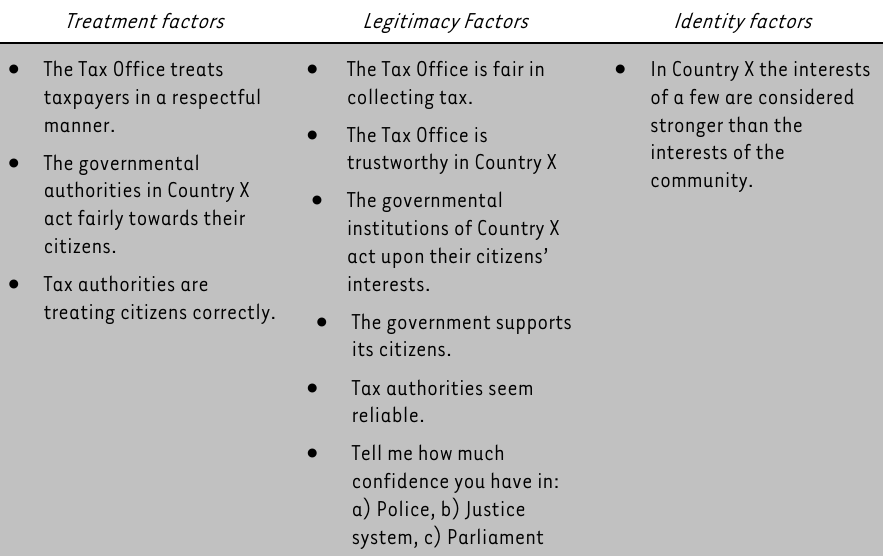
Typical questions or prompts used in surveys to elicit respondents’ perception of trust Treatment factors Legitimacy Factors Identity